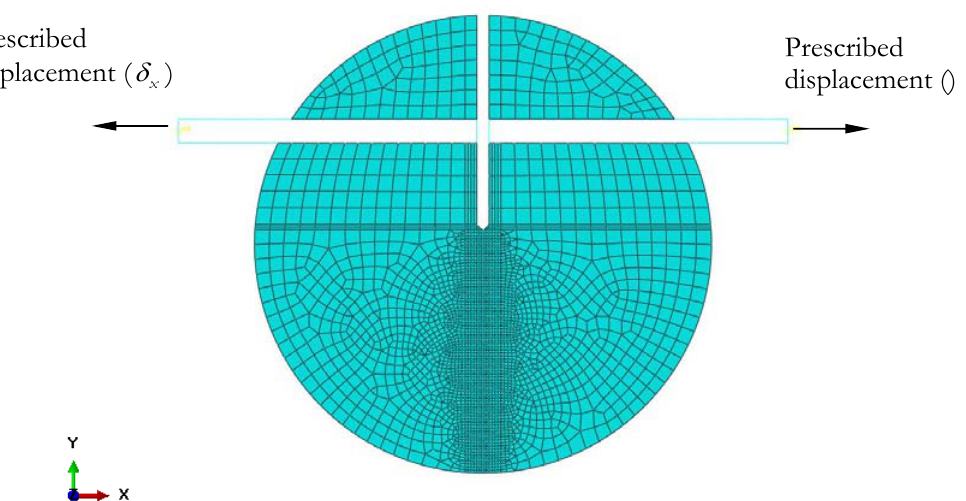
Figure 5: Mesh and boundary conditions for model